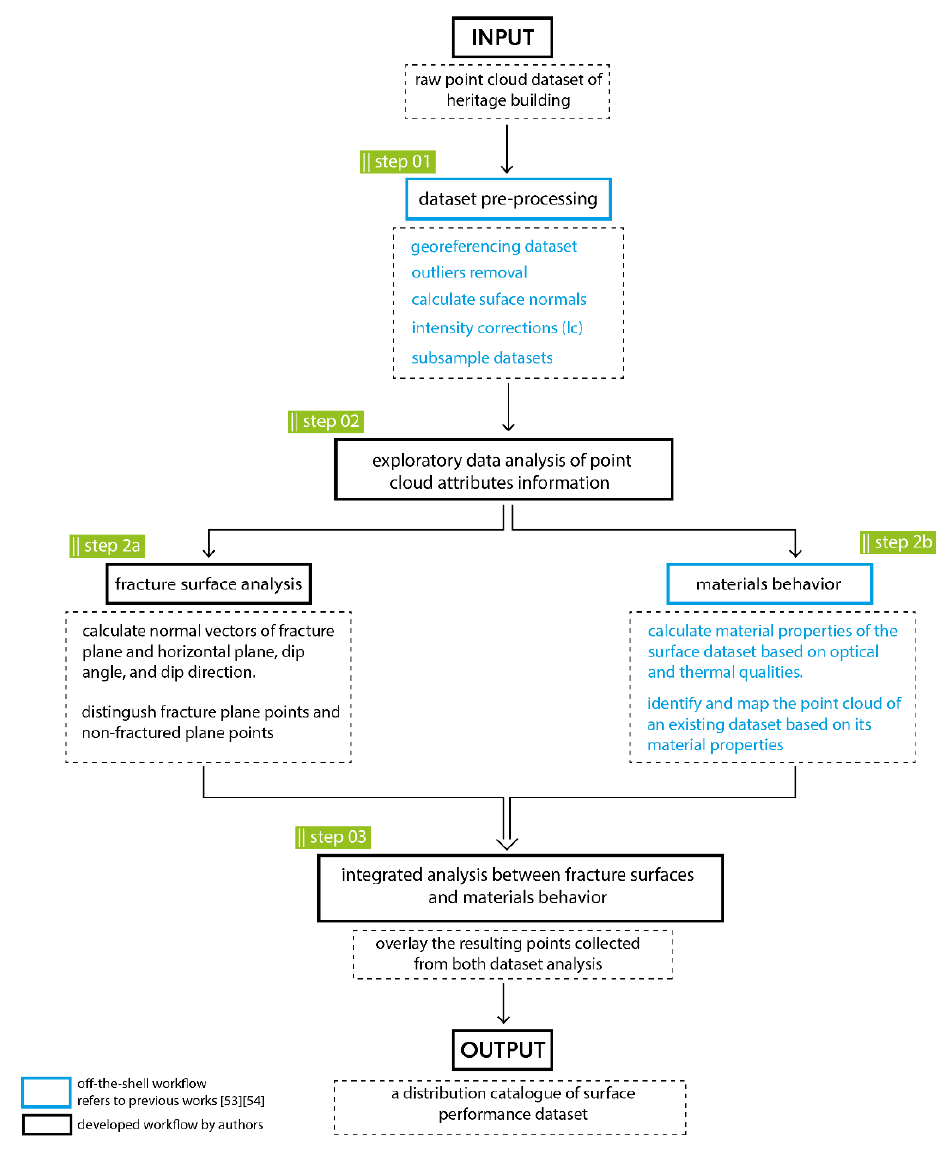
Figure 1. An overview of the proposed computational workflow.